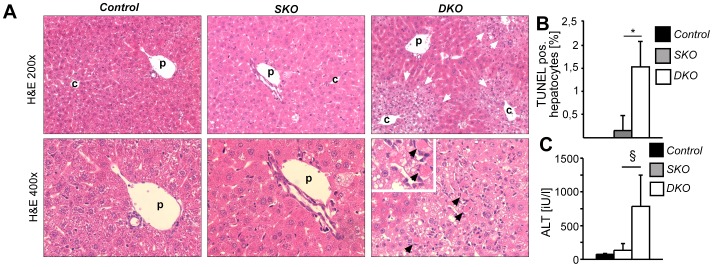
c-Jun attenuates liver damage following Apc
loss.
(A) Liver histology of mice with the indicated genotypes was analyzed 6 days after Cre induction. Pronounced hypertrophy of periportal hepatocytes was evident in DKO livers. By comparison, hepatocytes in the pericentral compartment (white arrows) were smaller and contained many vacuoles and scattered eosinophilic apoptotic bodies (black arrowheads; p, portal vein; c, central vein). (B) Apoptosis was analyzed by TUNEL assay, quantified and the hepatocyte apoptosis index is given in [%] ± S.D., (n = 3–4 livers/genotype). (C) Liver damage in mice with the indicated genotypes was determined by analysis of serum ALT ± S.D. 6 days after Cre induction (n = 5–11 mice/genotype; §, P<0.001).